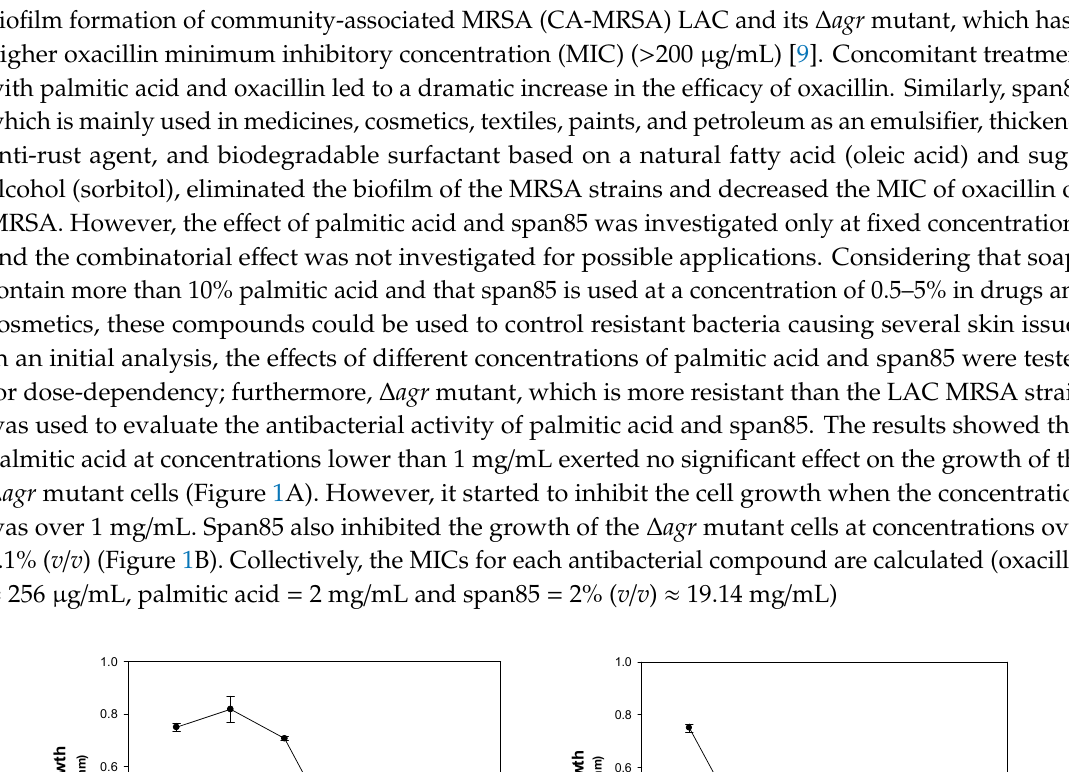
Table 1. Coded and real values of factors in the Box–Behnken experimental design.